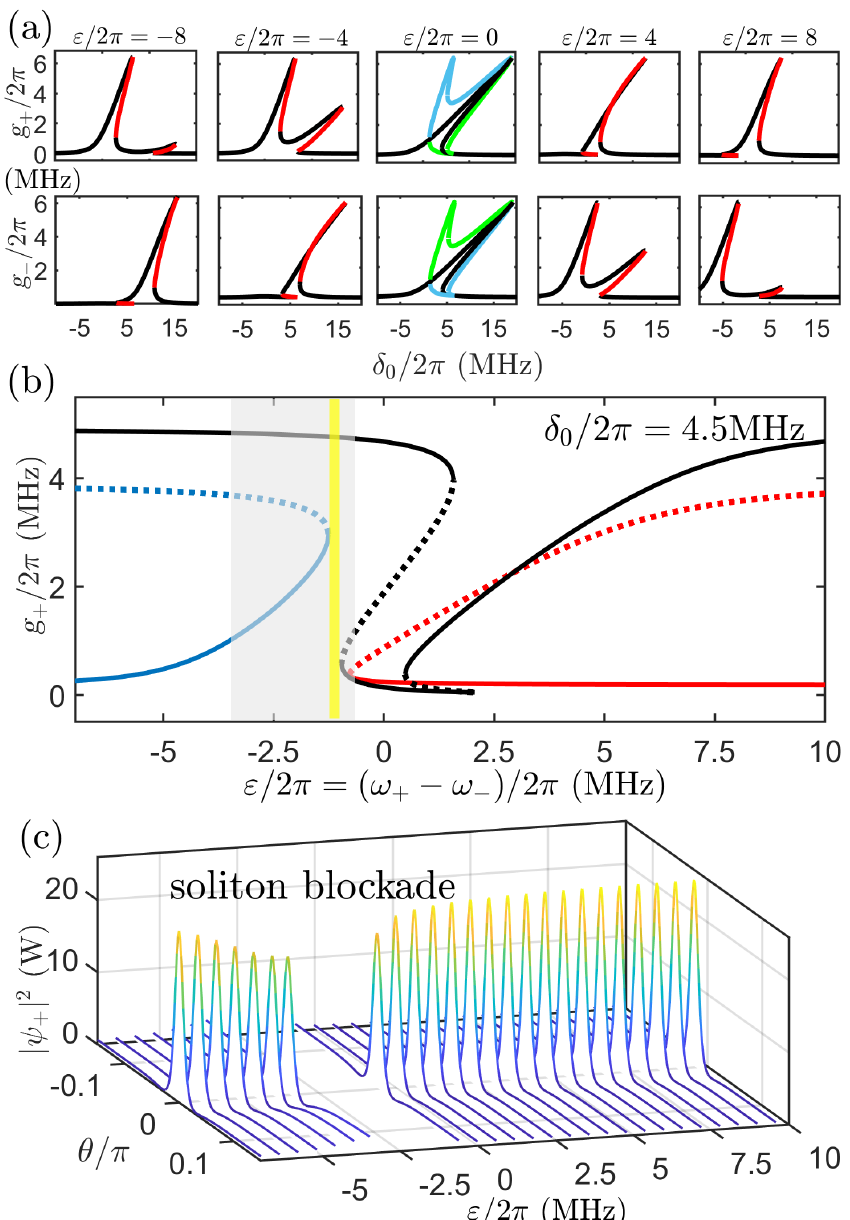
( cw ) | 2 for the cw-cw states vs. δ Figure 2. ( a ) g ± = γ | ψ 0 for a set of ε . ( b ) g + for the cw-cw state ± vs. ε for δ 0 /2 π = 4.5 MHz. ( c ) Angular profiles of the soliton-cw states vs. ε . The grey shaded interval in ( b ) and the no-solution interval in ( c ) is the soliton-blockade interval (see text for further details and the same and similar datasets published by us in [15]). Other parameters are H 2 ± = 16 W, κ /2 π = 1.5 MHz, F = 10 4 , D 2 /2 π = 10 kHz, γ /2 π = 0.4 MHz/W, η =